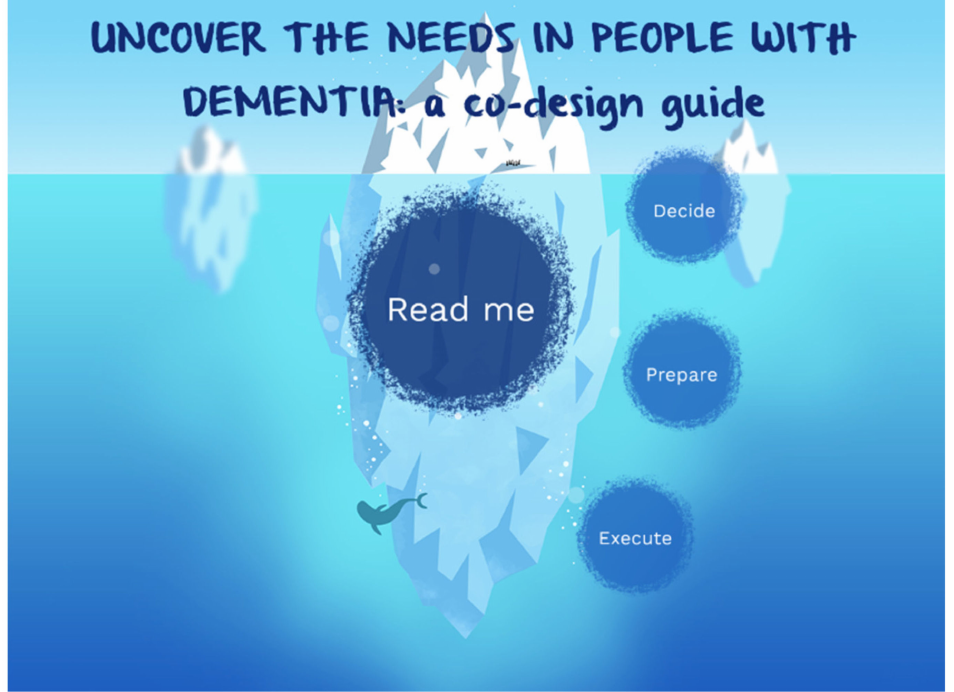
Figure 5. Home page of the co-design